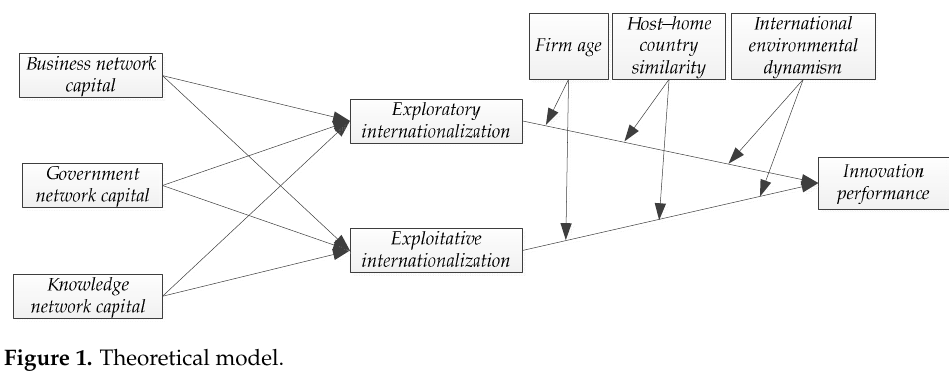
Figure 1. Theoretical model.